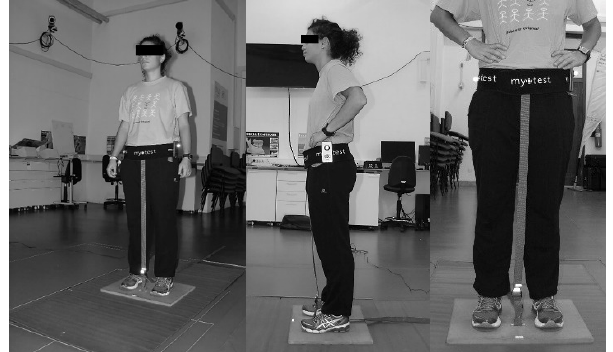
Figure 1. Vertical jump test.